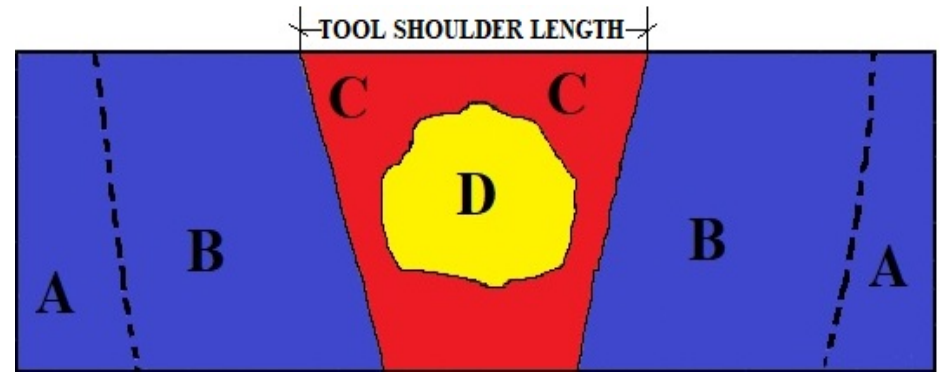
Figure 4. Microstructural zones.